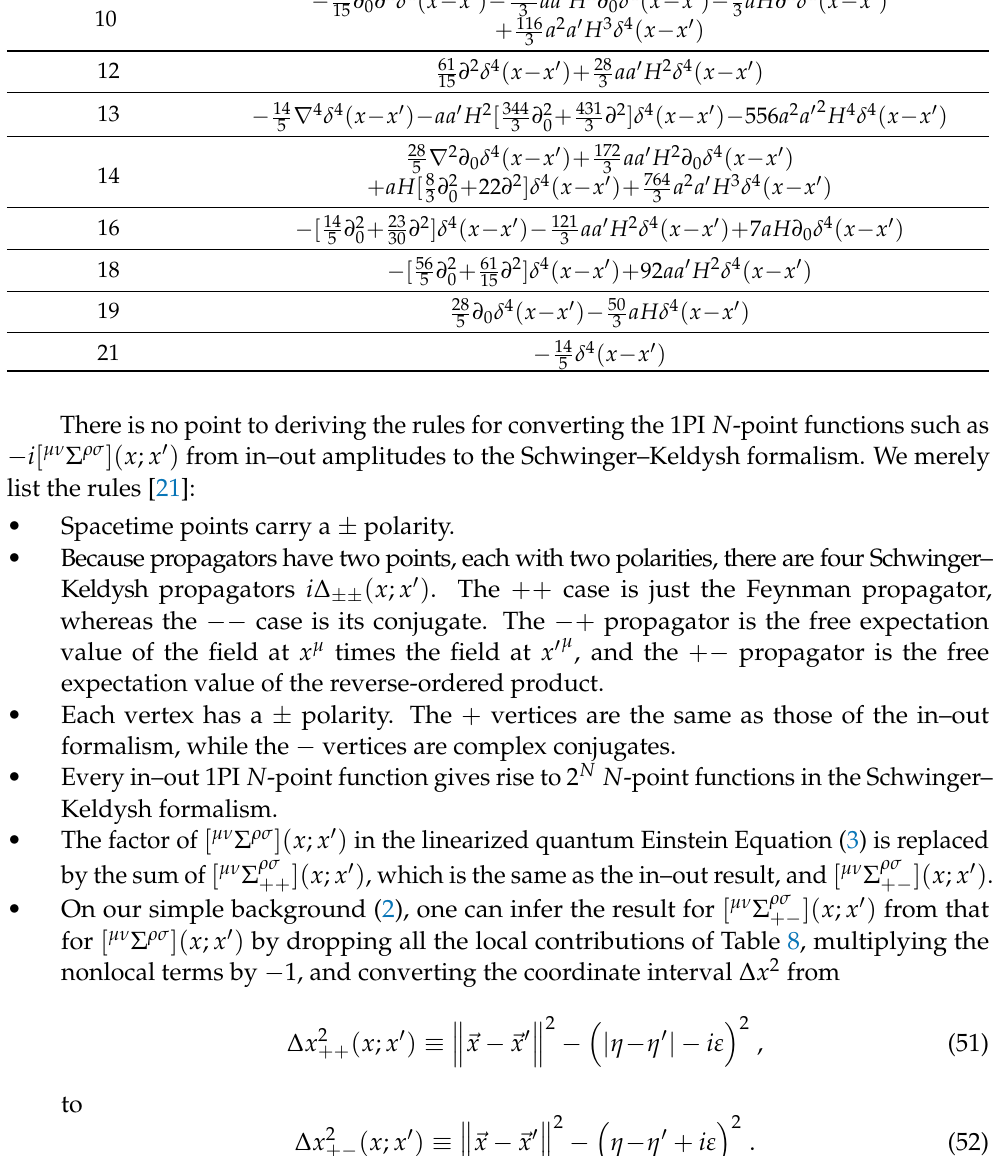
2 ln ( a ) . 32 π 2 ( x ; x (cid:48) SK